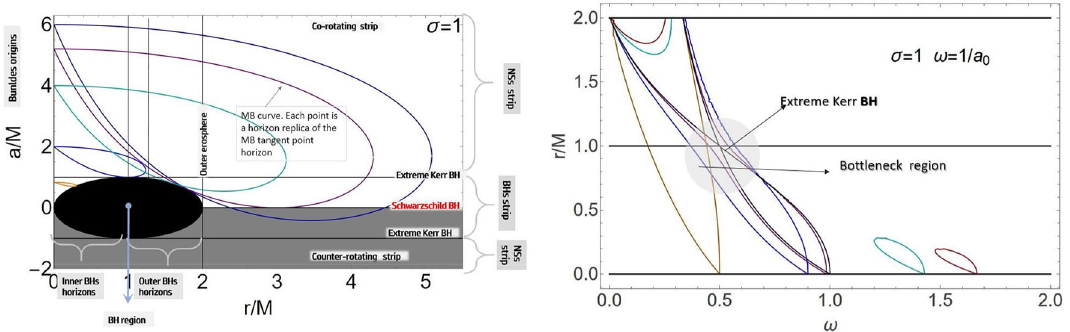
Fig. 1 Left panel: Extended plane a / M − r / M on the equatorial plane to the extreme Kerr BH . The frequencies of the inner and outer horizons (σ = sin 2 θ = 1 ) of the Kerr geometry. Metric bundles ( MB s) with = 1 / 2 corresponds curve are clearly distinguished. The frequency ω ± H characteristic frequency ω = 1 / a 0 = constant are shown for different to the extreme Kerr BH . On the equatorial plane, the point r = 2 M ω ,where a = 0).Theblack is the outer ergosurface (the Schwarzschild BH horizon for a = 0). 0 isthebundleoriginspin(bundlesvalueat r region represents the BH region with the outer and inner horizons a ± , Right panel: Light surfaces r ± s (ω ; a ) on the equatorial plane, solutions as functions of r / M ( M is the mass). A horizontal line on the extended of condition L N = 0, as functions of the frequency ω , for different plane at σ = 1 represents a fixed spacetime a / M = constant. In particu- spacetimes. Here, ω = 1 / a 0 corresponds to r = 0. The extreme BH lar, a = 0 corresponds to the Schwarzschild BH spacetime and a = M spacetime and the bottleneck region are also pointed